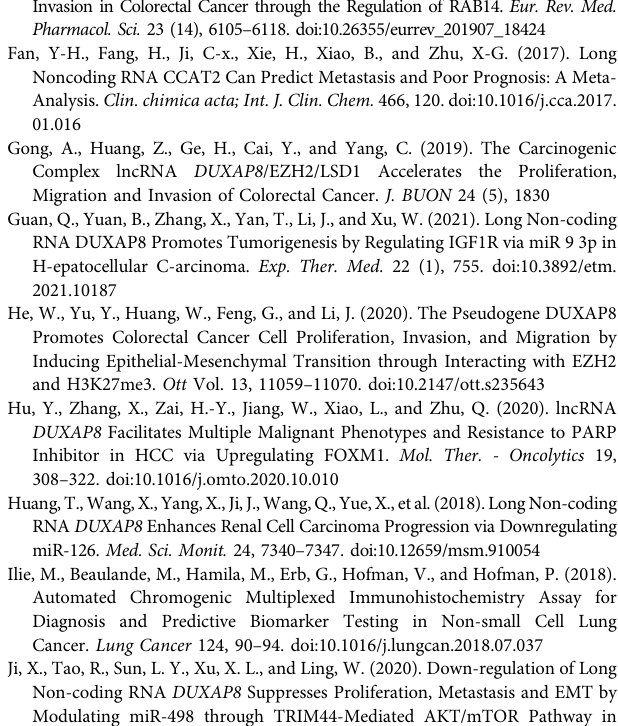
Supplementary Figure S1 | Flowchart showing the steps of study selection in this meta-analysis. Supplementary Figure S2 | Kaplan-Meier survival curves comparing high and low expression of DUXAP8 for different cancer types. (A) : OS of KIRC, KIRP, LIHC, SKCM, UCEC. (B) DSS of ACC, BRCA, KIRC, KIRP, READ, SKCM, STAD, and UCEC. (C) : DFI of COAD, LIHC, PRAD. (D) : PFI of ACC, KIRC, KIRP, LGG, LIHC, MESO, SKCM, and